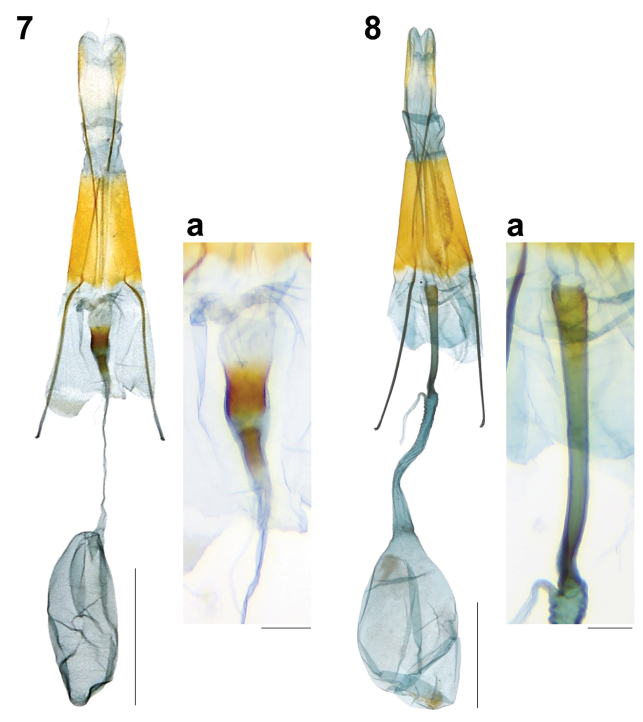
Female genitalia of Synanthedonini. 7Synanthedonauritinctaoidis Liang & Hsu, sp. nov. paratype (NTNU) 7a antrum. 8Paranthrenellahelvola Liang & Hsu, sp. nov. paratype (NTNU) 8a antrum. Scale bars: 1 mm; 0.1 mm (7a, 8a).